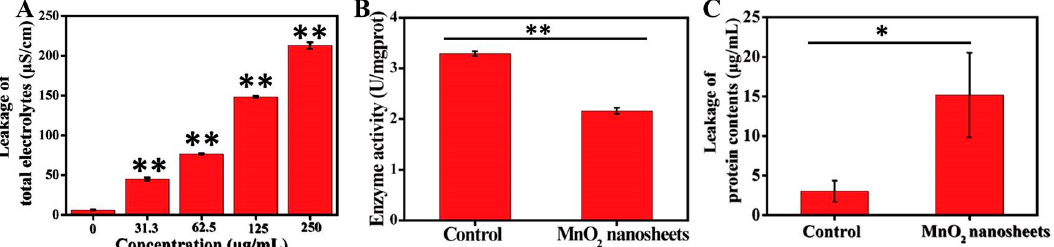
Figure 9. Measurement of total electrolytes of Salmonella after exposure to different concentrations of MnO 2 nanosheets ( A ). Measurement of total ATPase activity ( B ) and protein contents ( C ) of Salmonella after exposure to 125 μ g/mL MnO 2 nanosheets. Statistical significance was decided with a * p < 0.05 and ** p < 0.01.